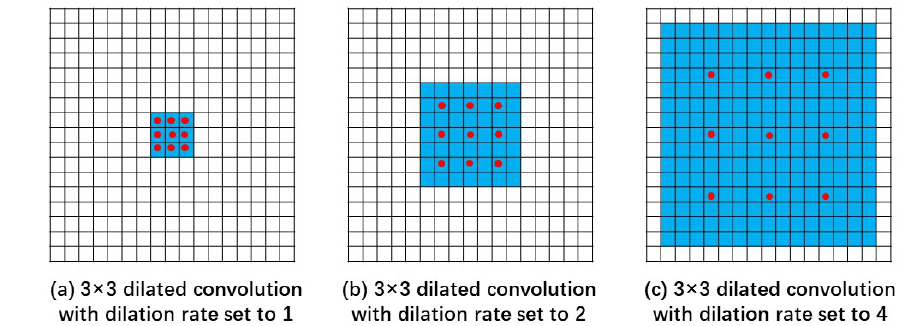
Figure 4. Schematic of dilated